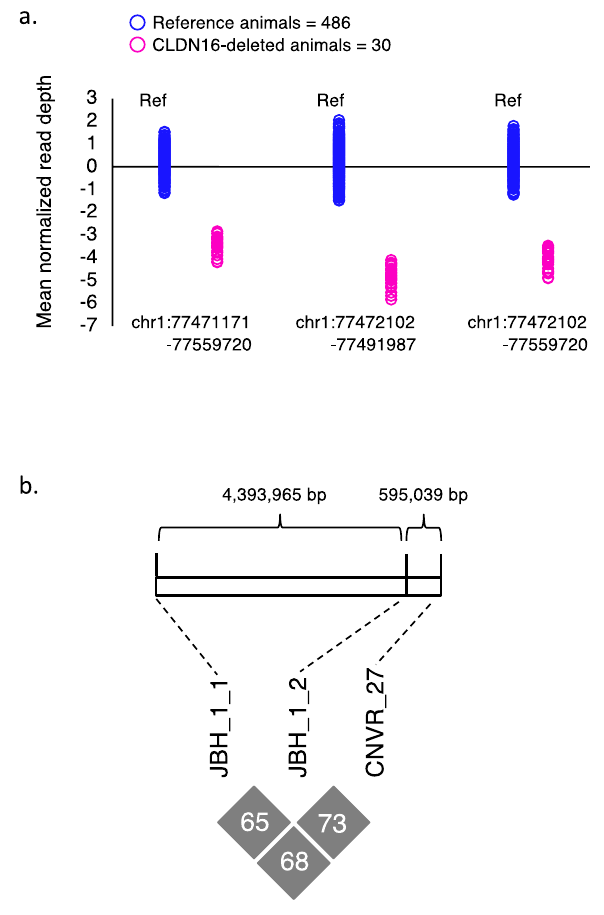
Figure 4. Relationships of CNVR_27 of CLDN16 in JBH_1_1 and JBH_1_2. ( a ) CNV calling of exome data in three ranges included CLDN16 exon 1 to exon 4, 77471171–77559720 bp, 77472102–77491987 bp, and 77472102–77559720 bp was performed using XHMM software. Mean normalized read-depth (X-axis) were calculated using the BAM file and plotted. ( b ) CNVR_27 of CLDN16 was located on the telomeric side at a distance of approximately 4.4 Mb from JBH_1_1 and 0.6 Mb from JBH_1_2. The r 2 values (LD) were estimated by the square of the correlation coefficient (%) in 1980 Japanese Black